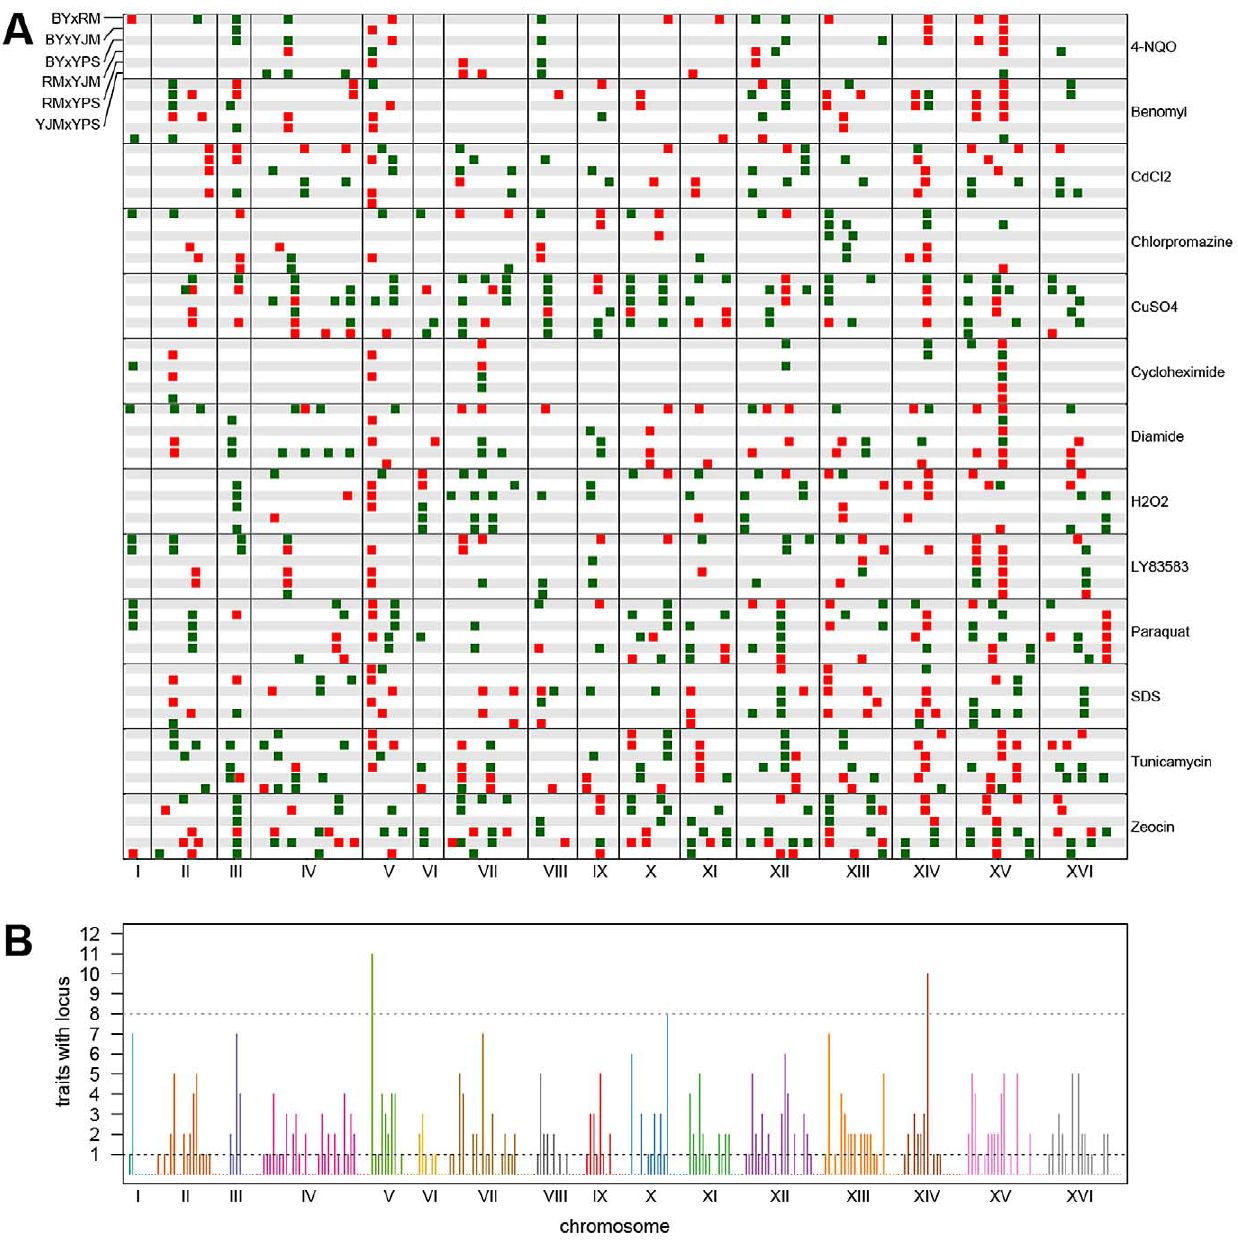
BYxRM, BYxYJM, BYxYPS, RMxYJM, RMxYPS, YJMxYPS. (B) The number of traits affected by loci within each 50-kb window. The grey dotted line shows the threshold for significance, while the black dotted line highlights the bins in which only one trait was